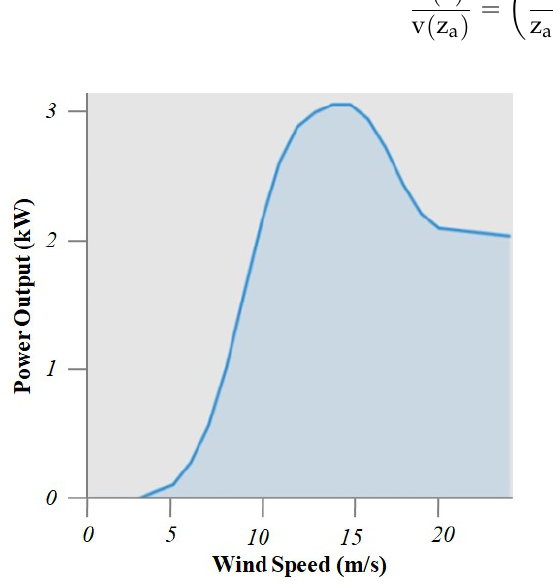
Figure 10. The power curve of the wind turbine.